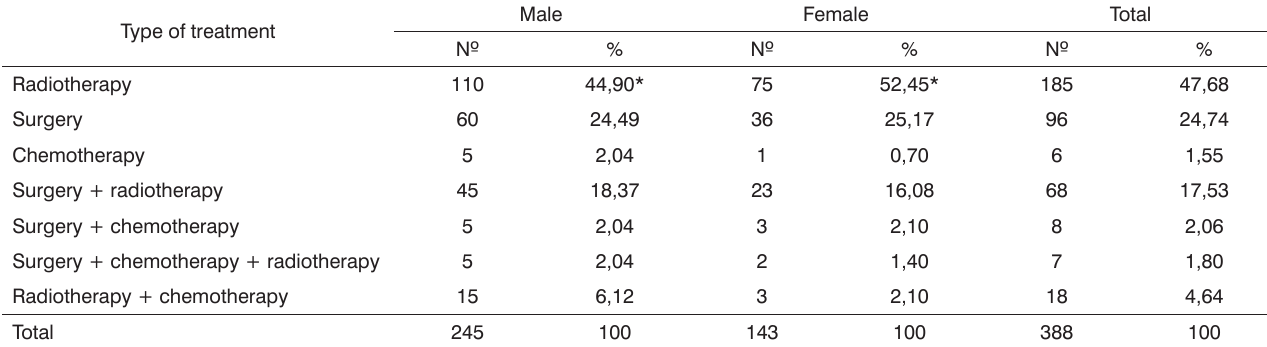
Table 4. Distribution of mouth squamous cell carcinoma patients according to the type of treatment Maceio-AL, 2000-2006.